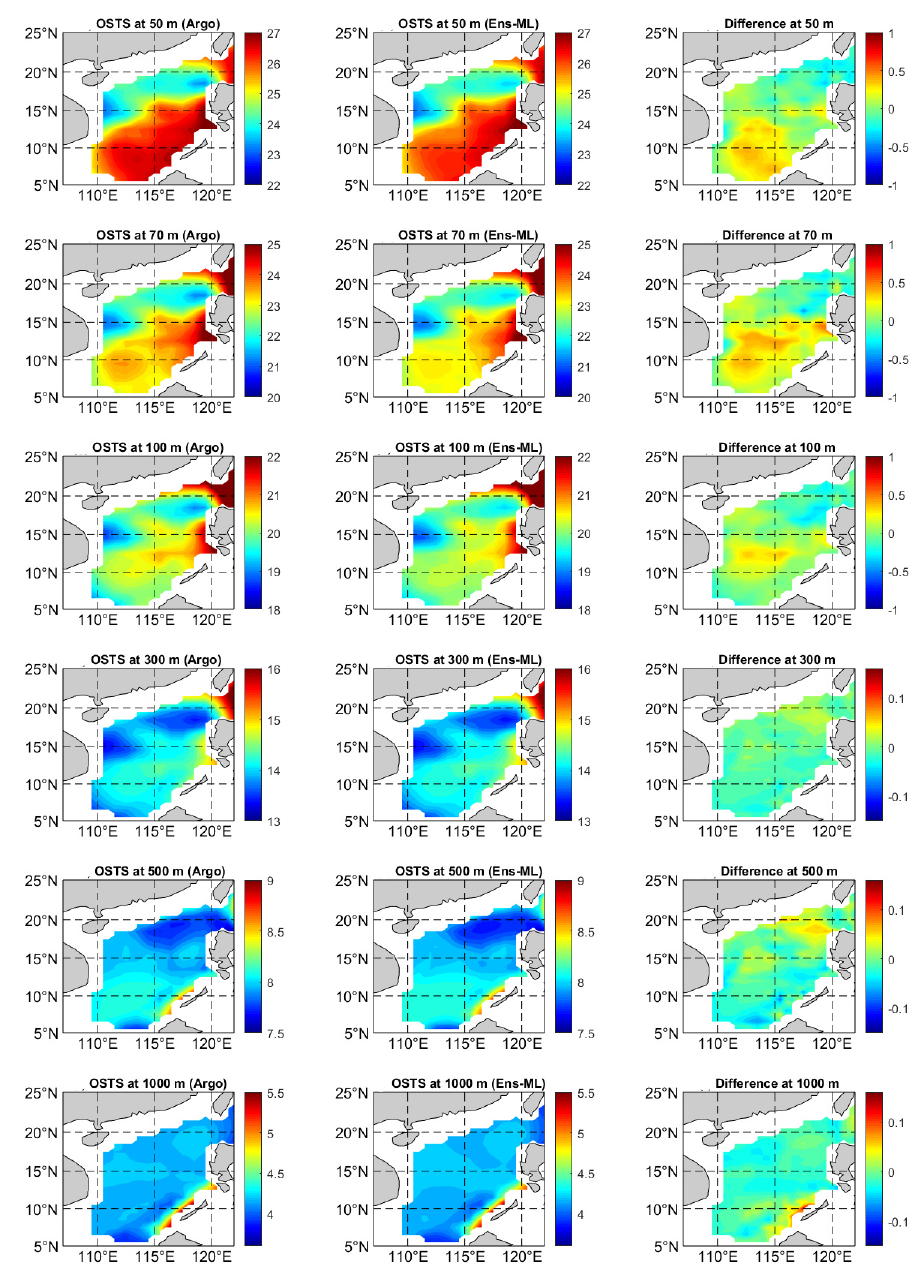
Figure 5. Argo-derived ( left panel), Ens-ML estimated yearly mean temperature ( middle panel) and the differences between the Argo and Ense-ML model ( right panel) at different depths (50, 70, 100, 300, 500, 1000 m) in 2019.